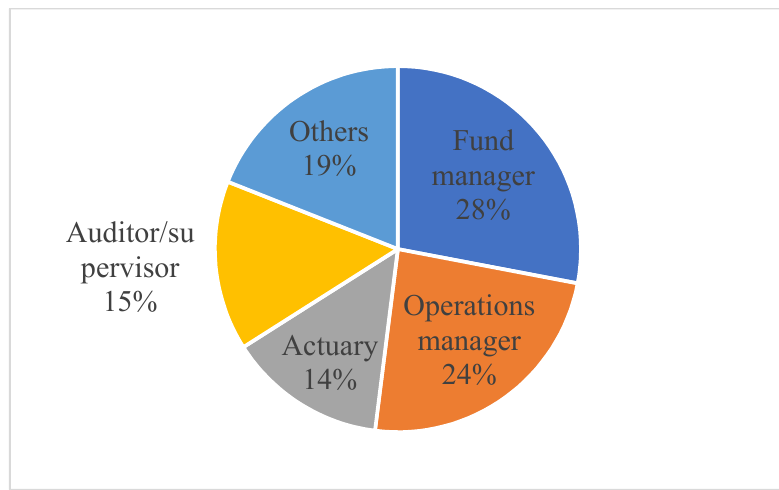
Figure 2. Job titles of the respondents.